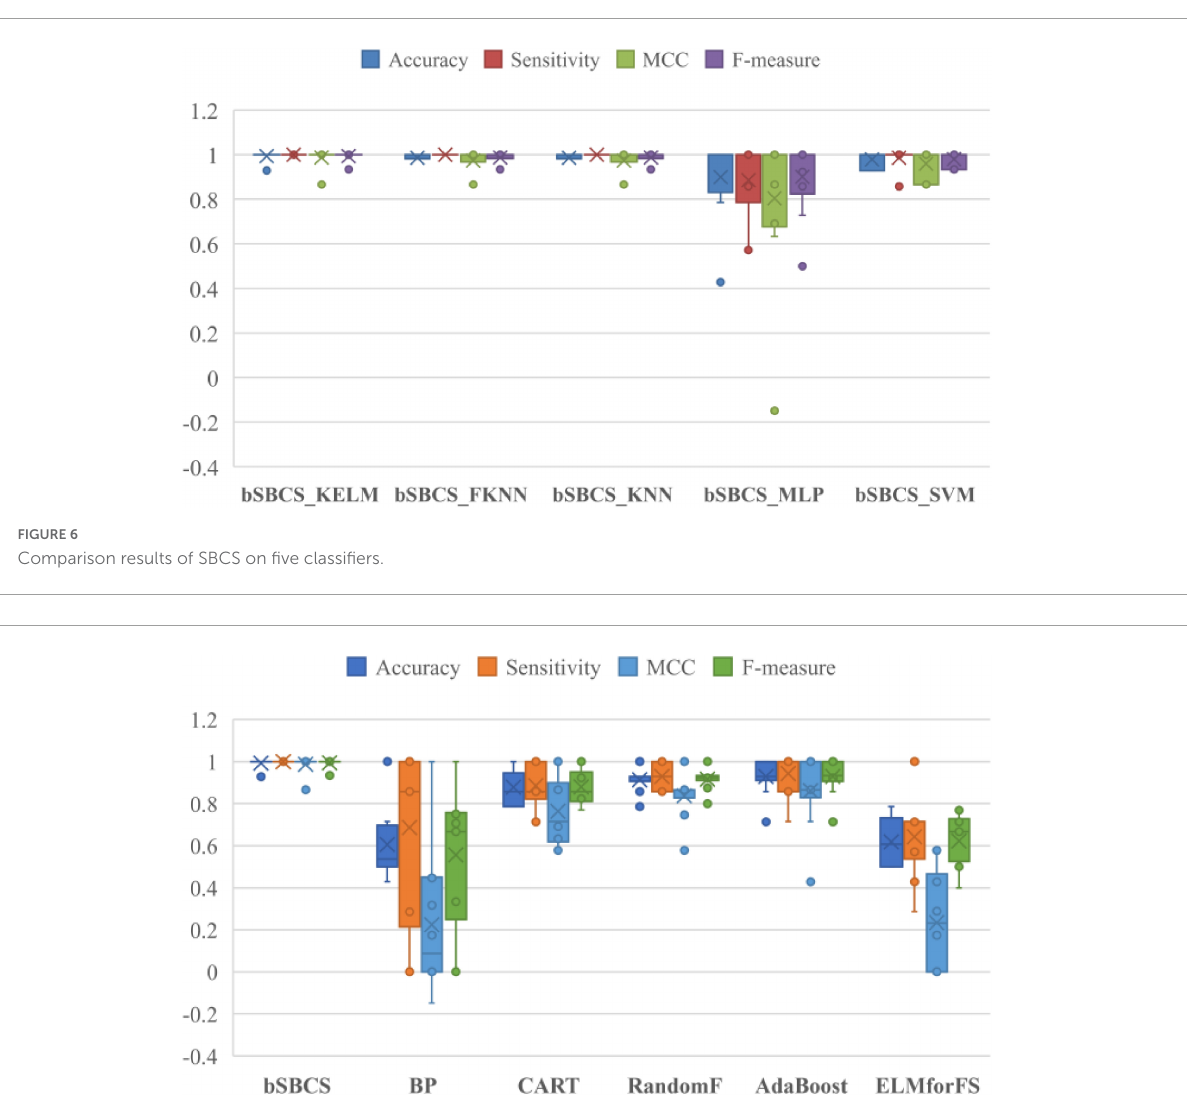
FIGURE7 Comparison of bSBCS and other well-known machine learning